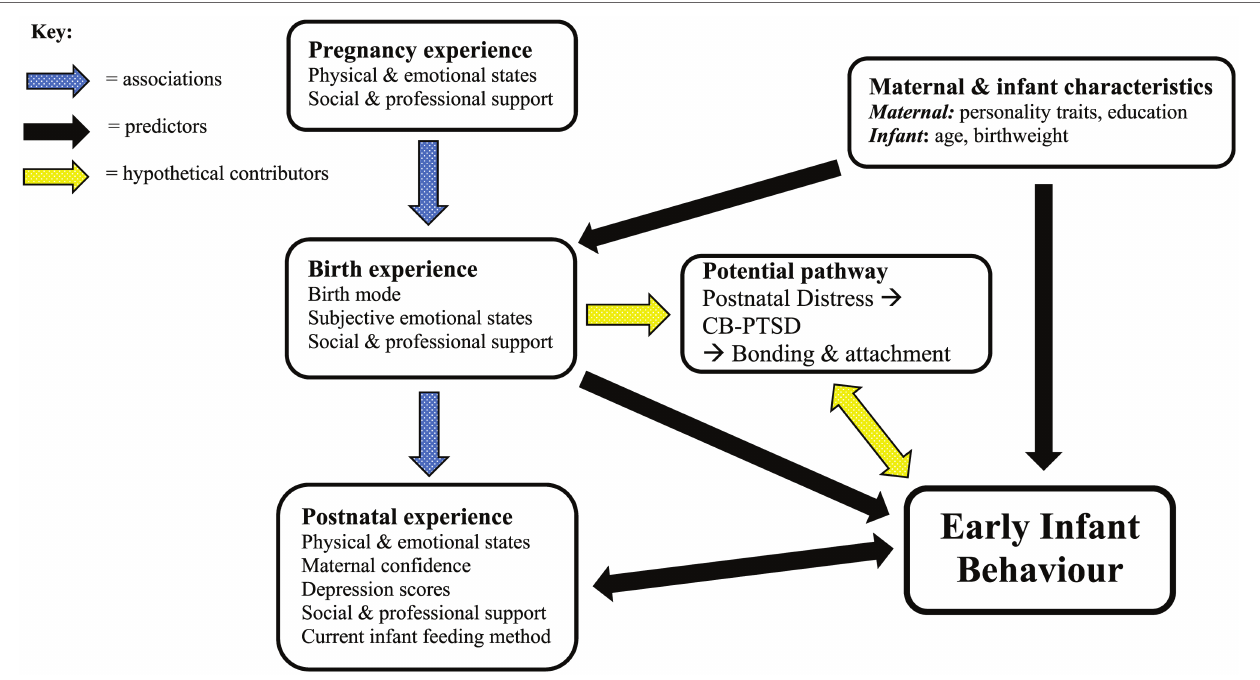
FIGURE 2 | A theoretical model of perinatal factors contributing to early infant